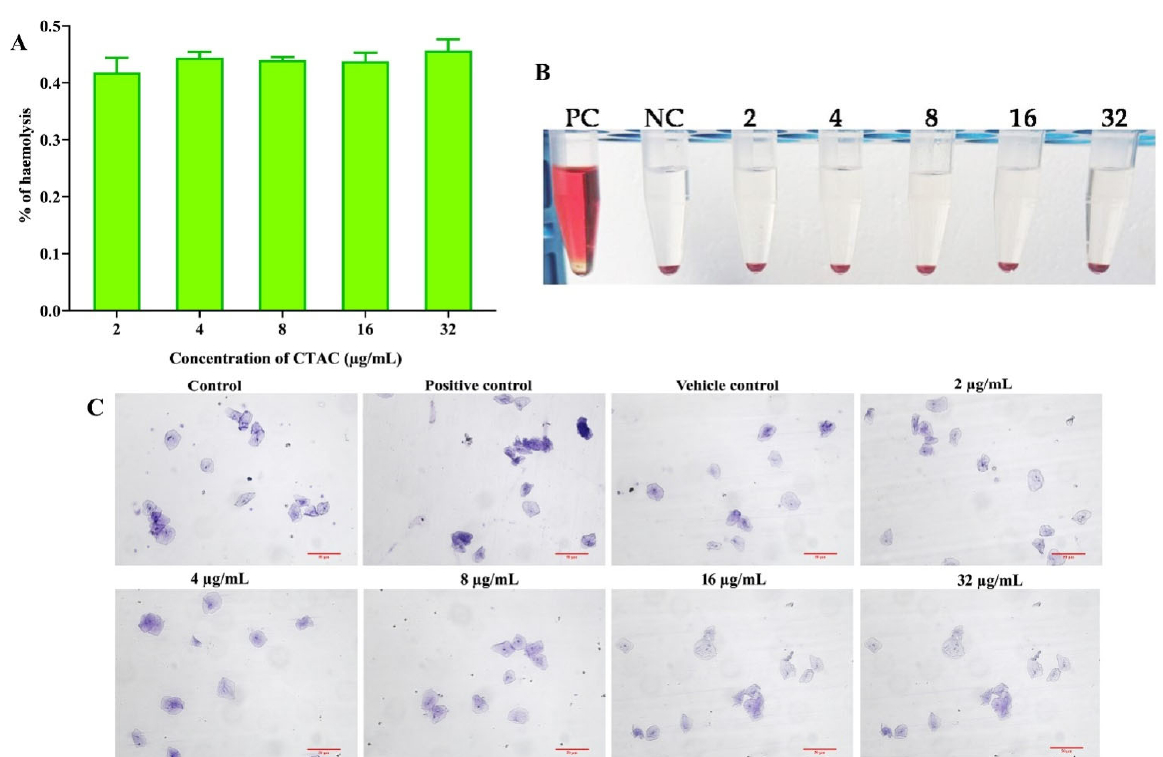
Figure 8. Assessment of CTAC cytotoxicity and HBECs. ( A ) Effect of CTAC on human red blood cells. No hemolytic activity was observed. The graph was plotted with absorbance using Triton X ‐ 100 as positive control, which seemed to completely lyse the total erythrocytes. ( B ) Representative image showing the non ‐ hemolytic activity of CTAC. ( C ) No toxic effect was observed on HBECs when hydrogen peroxide and water were used as positive and vehicle control. Light micrograph magnification 200×, scale bar 50 μ m.